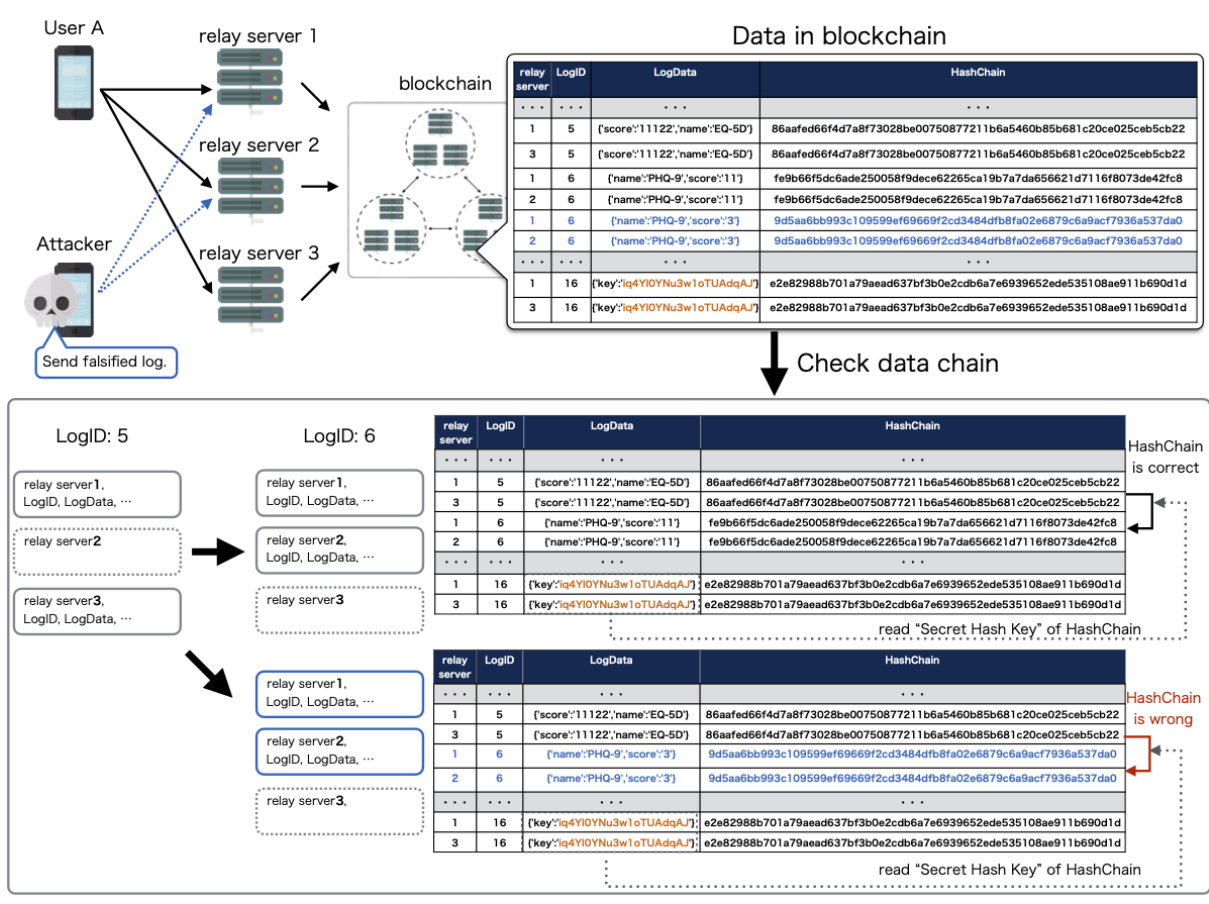
Figure 7. Simulation of data falsification by client impersonation. If an attacker successfully logs into the app using a stolen account or brute force attack, the attacker can create clinical data from another client device. The data from the impersonated client will be denied since only the true participant’s app preserves the secret hash key that is required to calculate the hashchain.